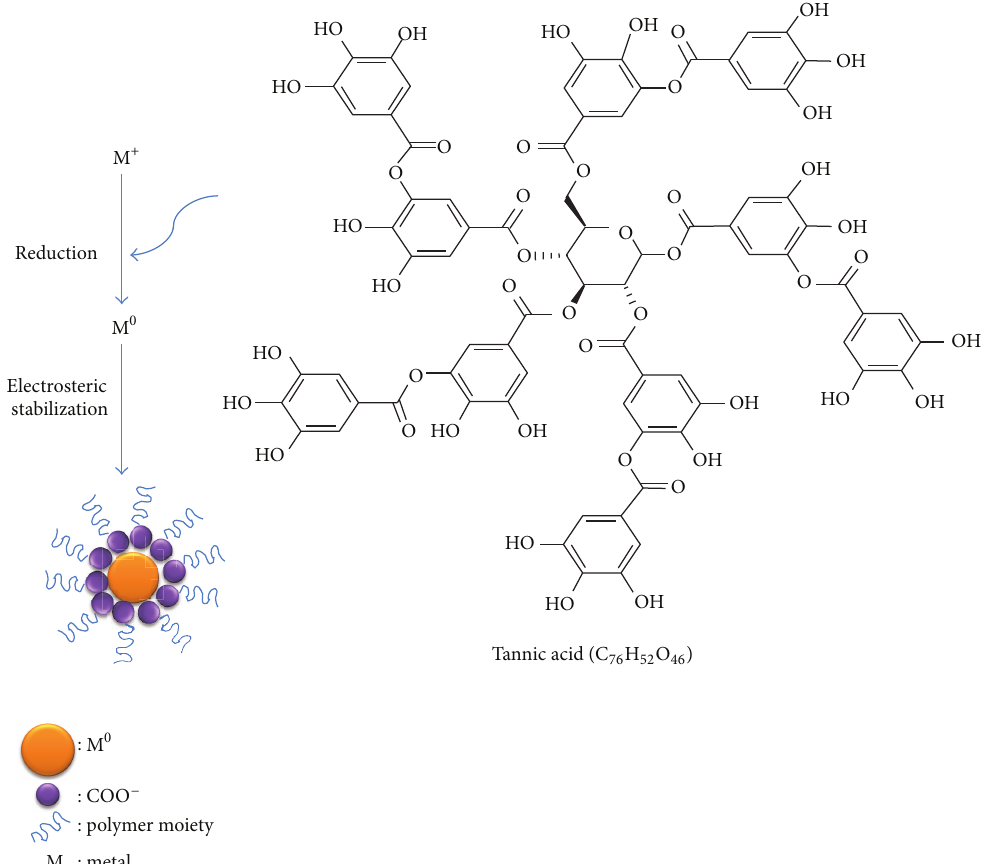
Figure 3: Putative mechanism of metal nanoparticle synthesis and stabilization by tannic acid.